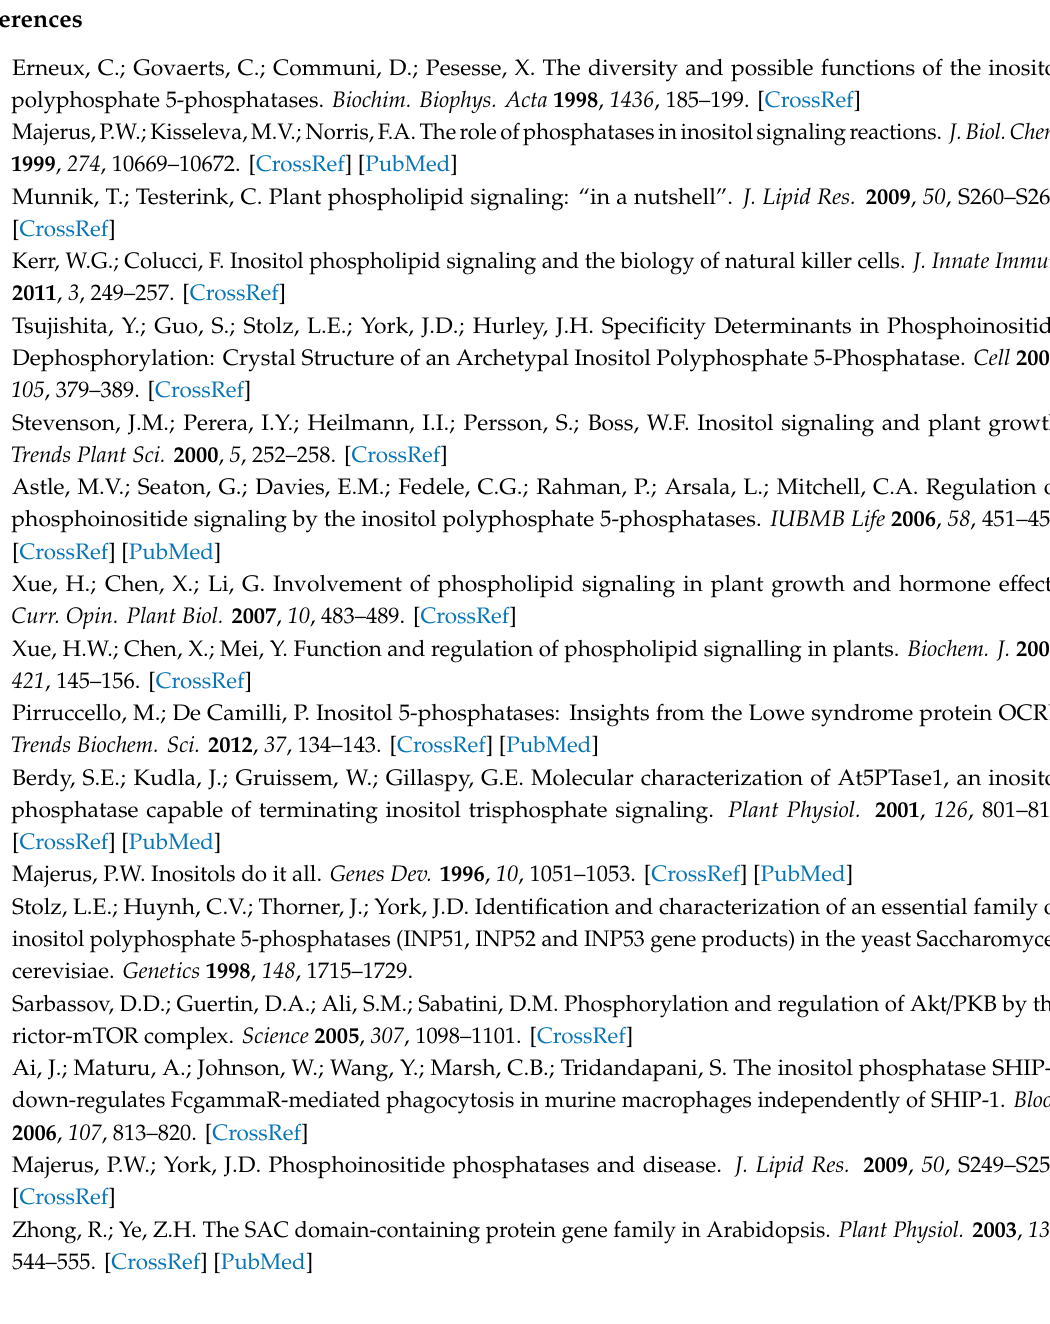
showing the expression of soybean 5PTases in di ff erent tissues, Figure S4. Expression of soybean 5PTase genes under drought, cold, and heat